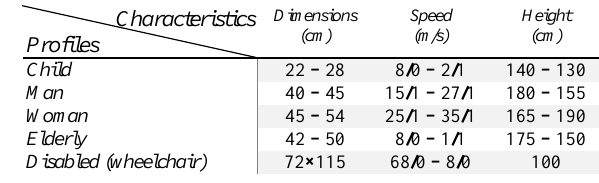
Table 2. A sample of the residents at the case study, in NFPA and SFPE evacuation simulation.